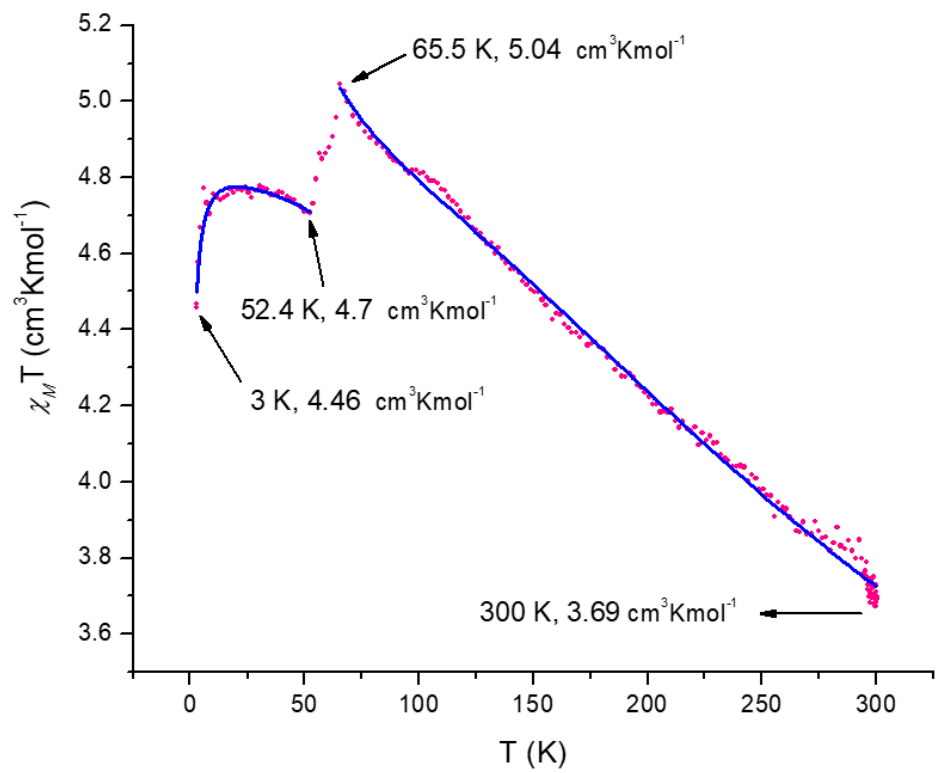
Figure 8. Magnetic susceptibility dependence on the temperature for 1 . The blue solid lines correspond to the best fit using eq 3. The correlation coefficients values were: for total data, for χ M T vs T ( 300 − 65.5 K ) r 2 = 0.90 and T ( 65.5 − 3 K ) section of r 2 = 0.999.